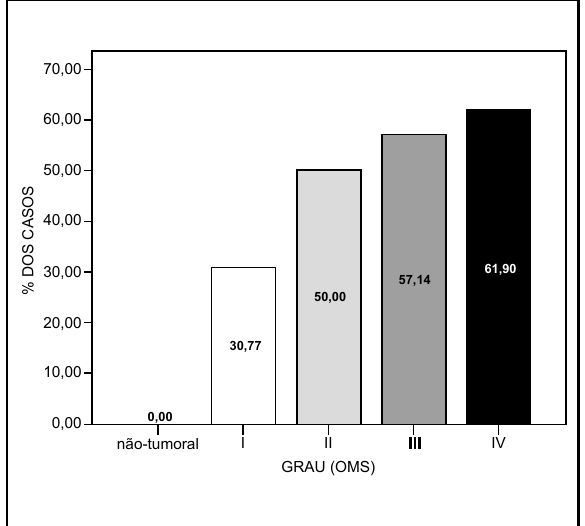
Figura 4 – Distribuição percentual das diferentes classificações histológicas segundo a tendência à sobrevida estimada pelo equilíbrio entre as expressões das proteínas BCL-2 e BAX detectadas por